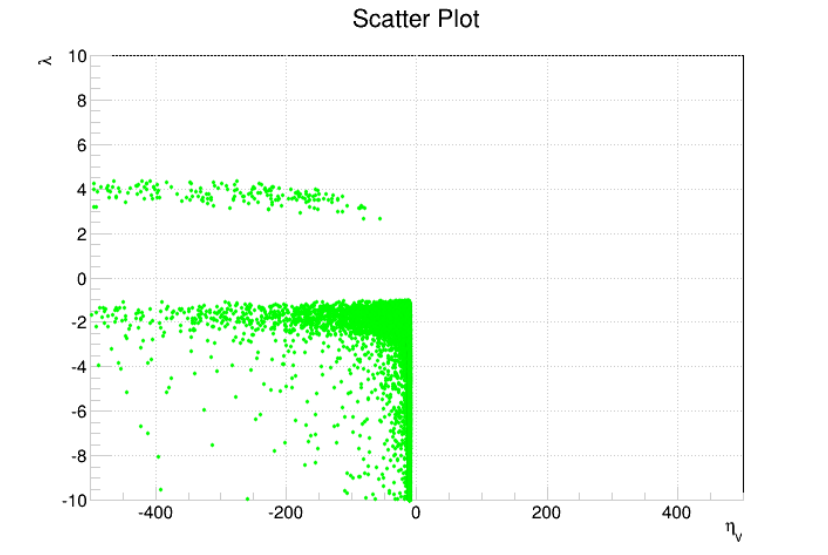
Figure 1 . Scatter plot of solution space showing the bound \wall" close to a (cid:0)O (1)